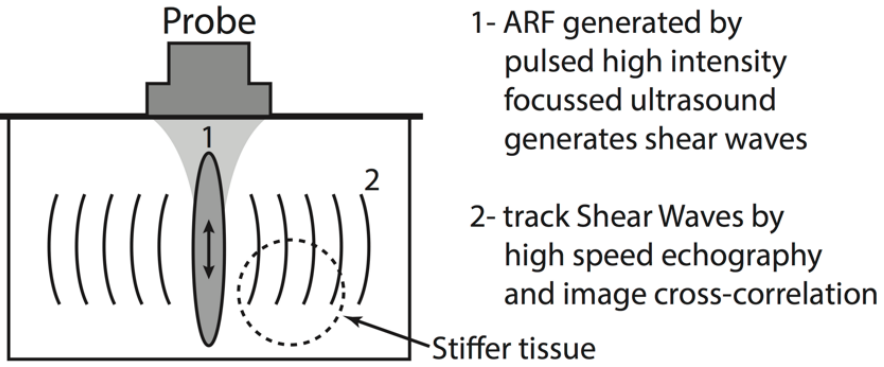
Figure 1. Schematic principle of